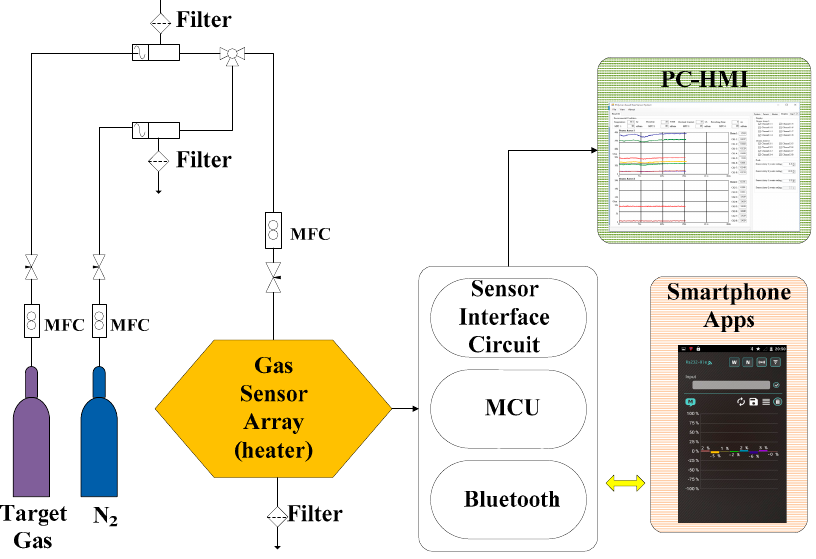
Figure 11. Experimental setup of sensing response system.